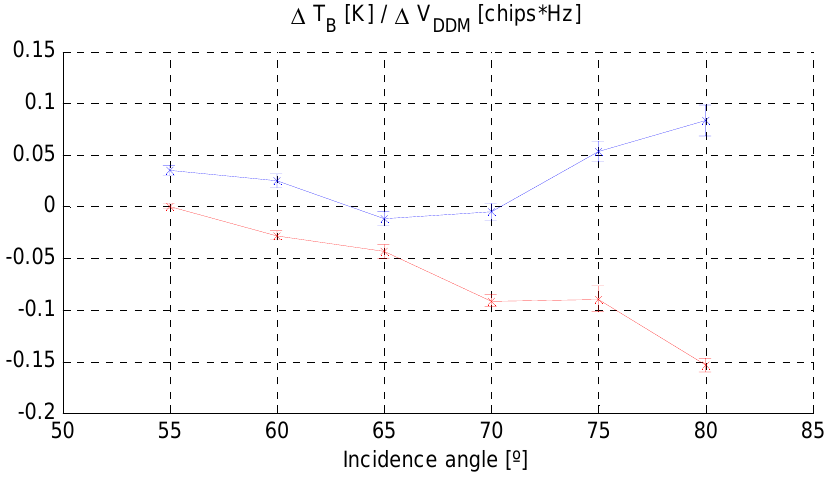
Figure 16. Estimated brightness temperature sensitivity to changes in the normalized DDM volume at vertical (red) and horizontal (blue) polarizations respecively